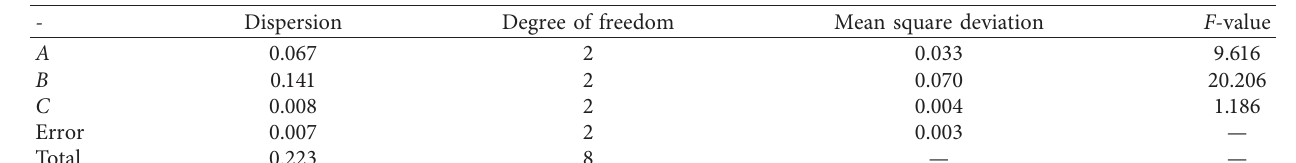
Table 12: Variance analysis